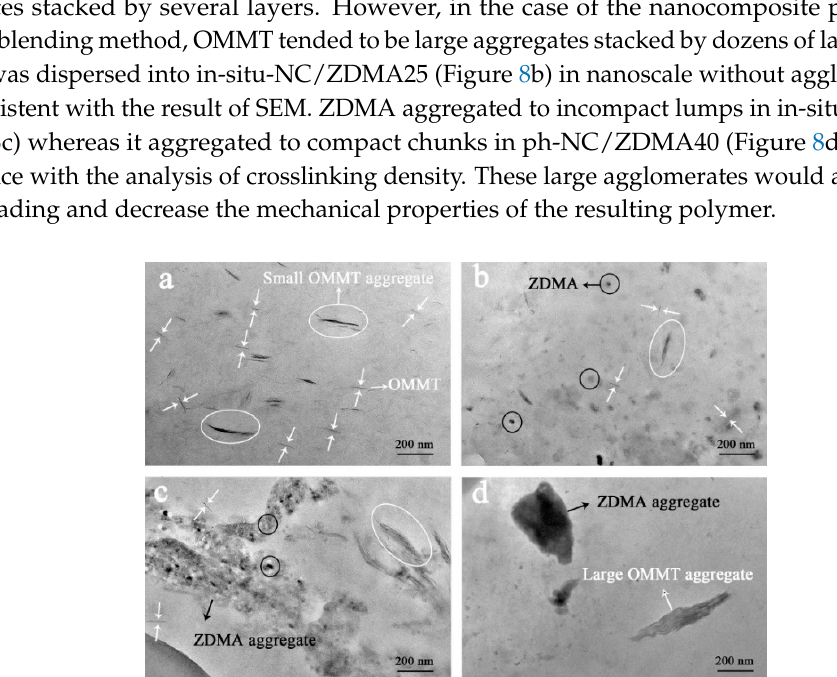
Figure 8. ( a ) TEM images of in-situ-NC, ( b ) in-situ-NC/ZDMA25, ( c ) in-situ-NC/ZDMA40, and ( d ) ph-NC/ZDMA40.